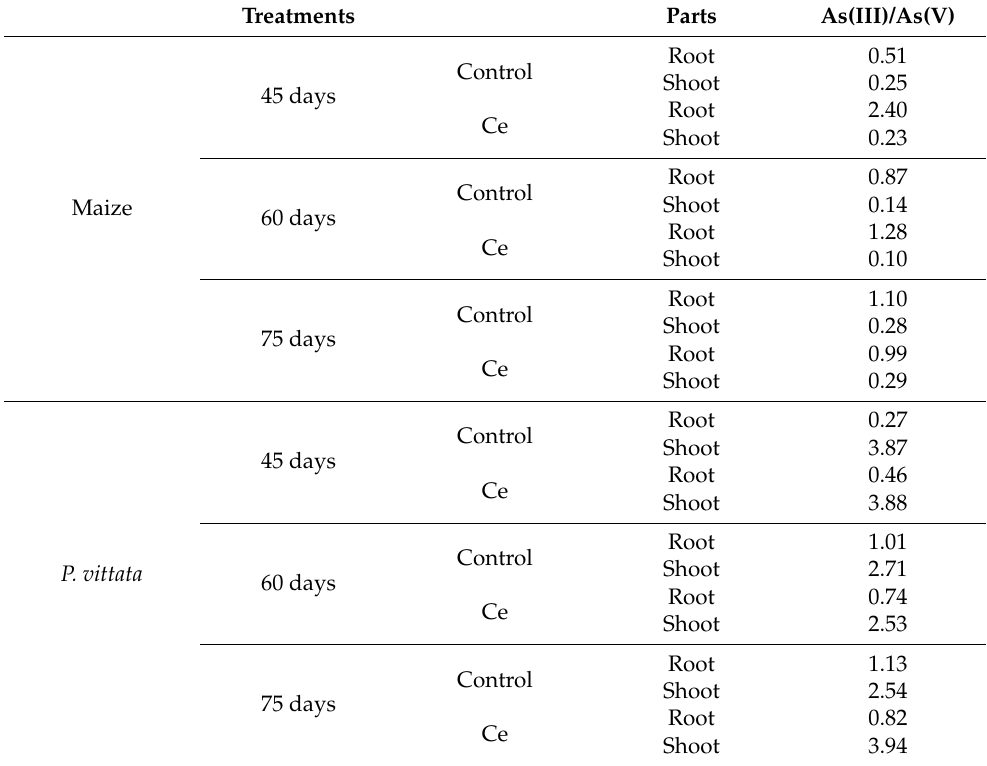
Table 3. The ratios of As(III)/As(V) in different parts of maize after colonization by Ce under As stress in different periods.